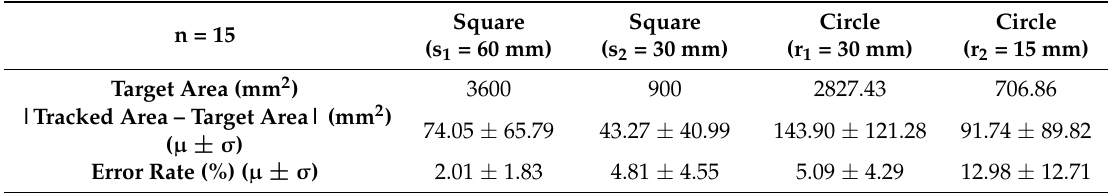
Figure 3. Graph highlighting target trajectories (blue lines) and tracked trajectories (gray lines) within the X–Y cartesian plane: ( A ) square shaped; ( B ) circular shaped. The gray lines starting at the origin represent the path to reach the target trajectories. Table 1. Results from characterization of the apparatus.